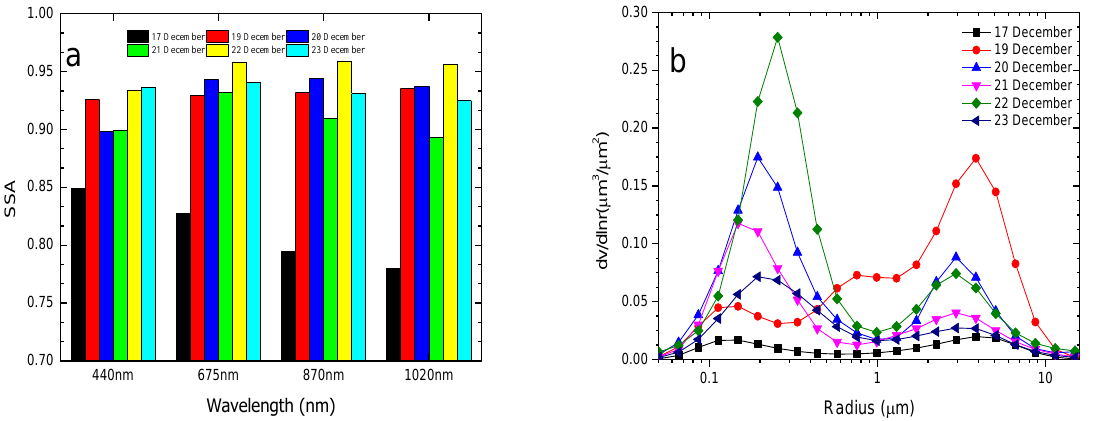
Figure 7. The ( a ) SSA and ( b ) aerosol volume size distribution measurements in Beijing during 17–23